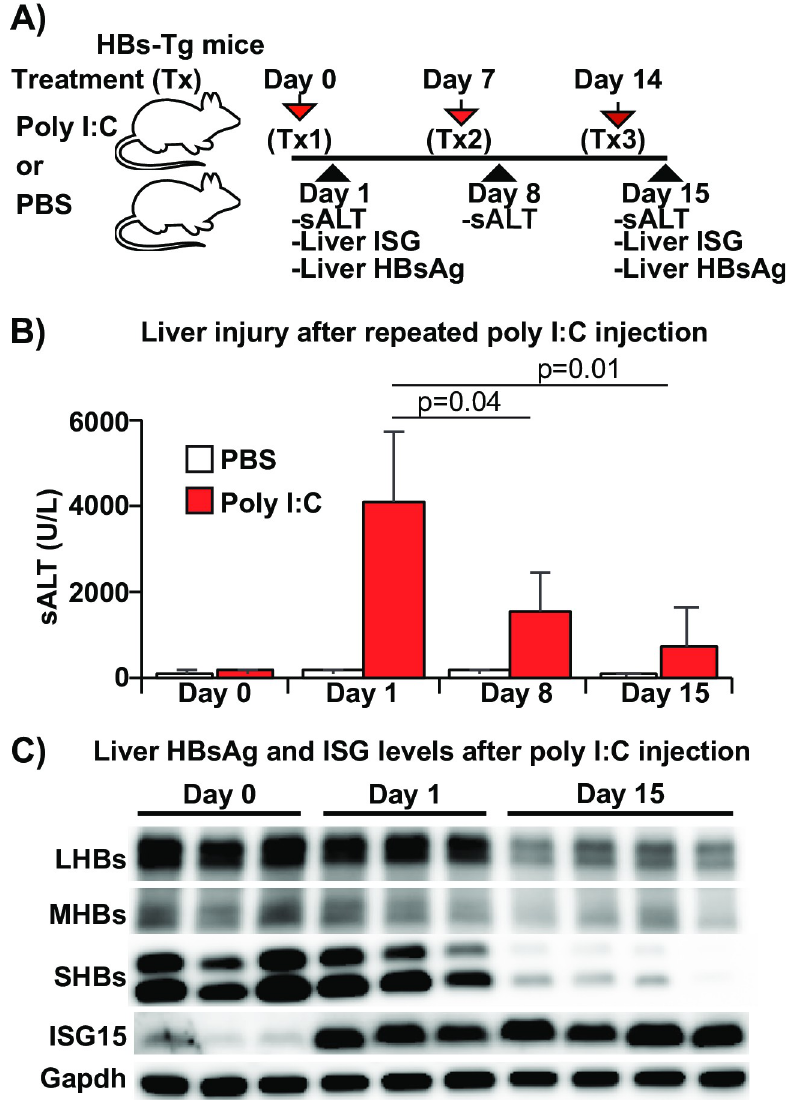
Fig 3. Reduction of intrahepatic HBsAg alleviates poly I:C mediated liver injury. (A) Experimental design. HBs-Tg mice were intraperitoneally injected with poly I:C (10 μ g/mouse) or saline on days 0, 7 and 14. Serum ALT, intrahepatic ISG15 and HBsAg levels were monitored at the indicated time points. (B) Serum ALT levels before (day 0) and after poly I:C injection (days 1, 8 and 15). (C) Intrahepatic expression levels of HBsAg and ISG15 after repetitive poly I:C treatment. Representative immunoblots showing HBsAg and ISG15 levels on days 0, 1, and 15.